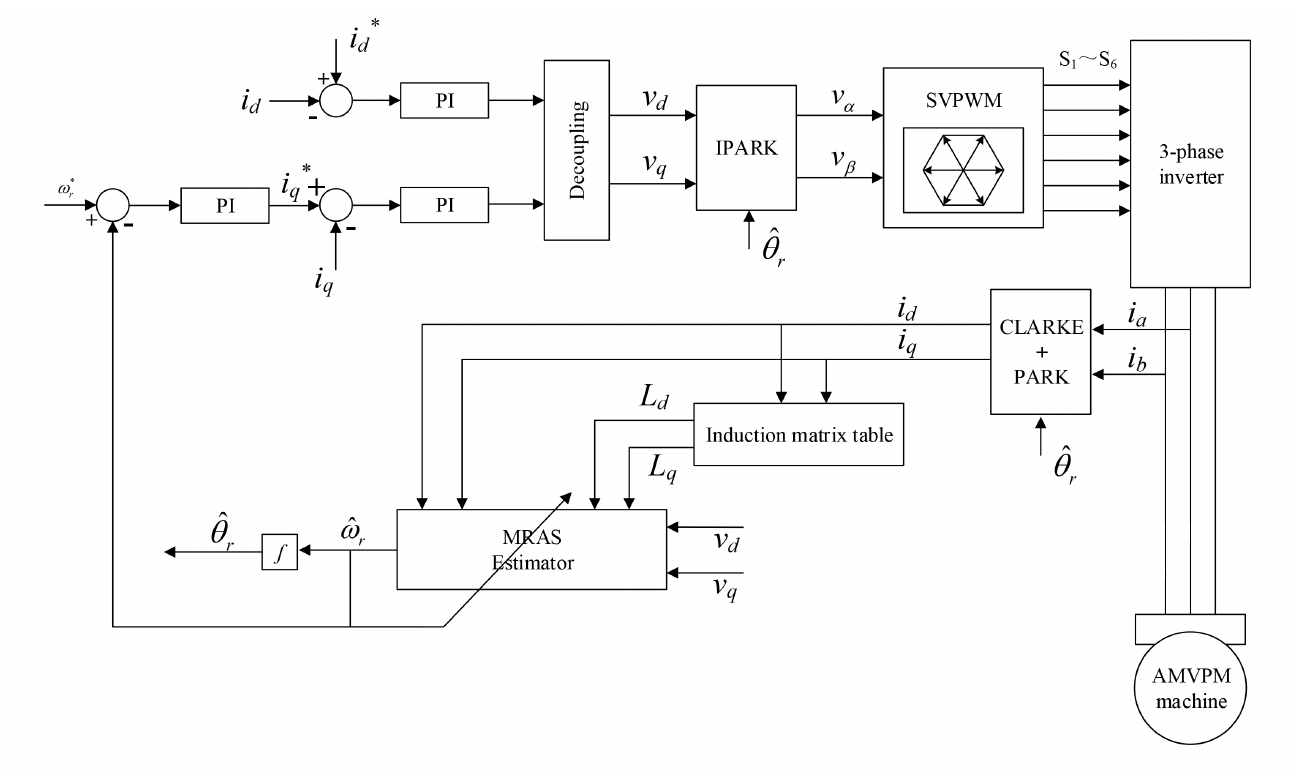
Figure 8. The global sensorless vector control system